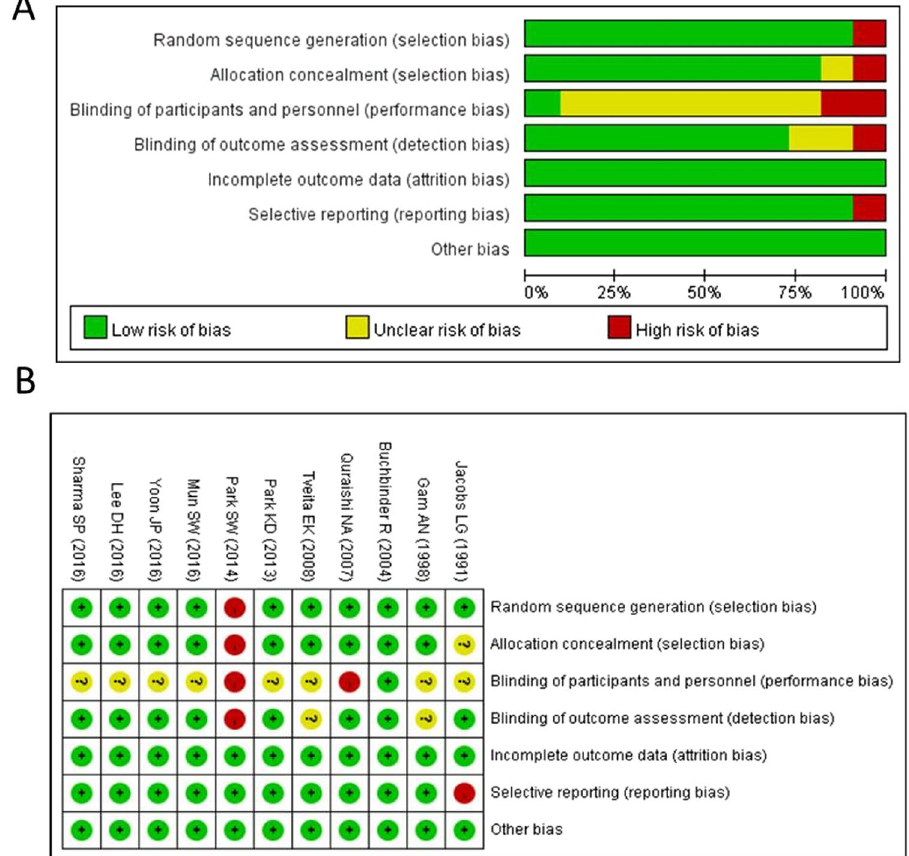
Figure 2. Summary graph ( A ) and table ( B ) of risk of